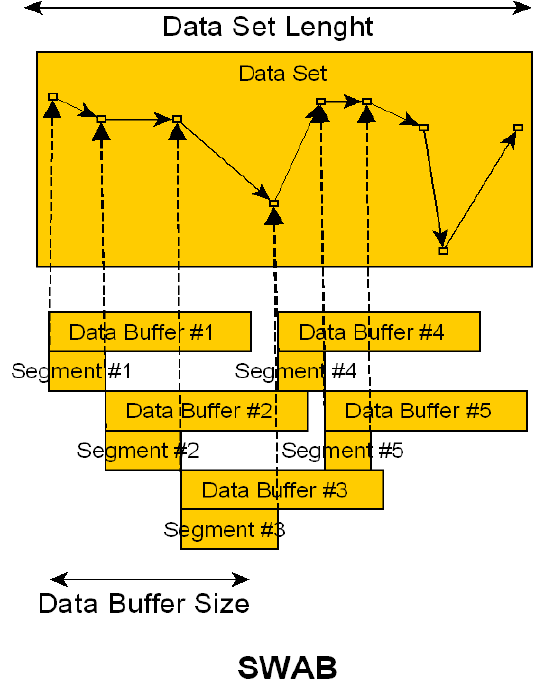
Figure 3. Explanation of segmentation method